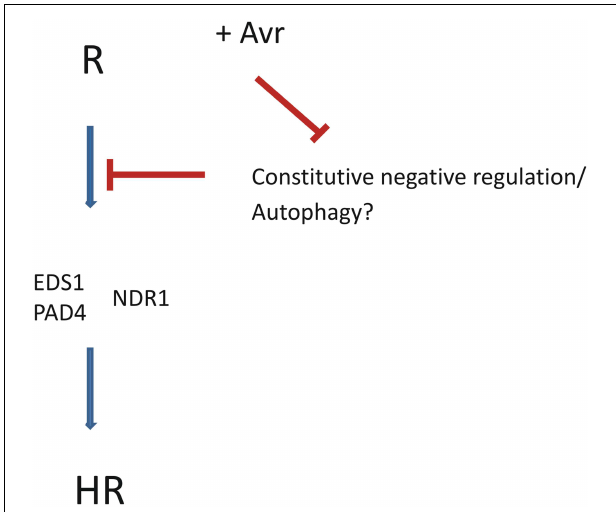
FIGURE 1 | The plant constitutively negatively regulates R protein function. The interaction R-Avr serves mainly to release this negative regulation. The important component of negative regulation is autophagy; when it is non-efficient, R proteins spontaneously over activate defense responses.